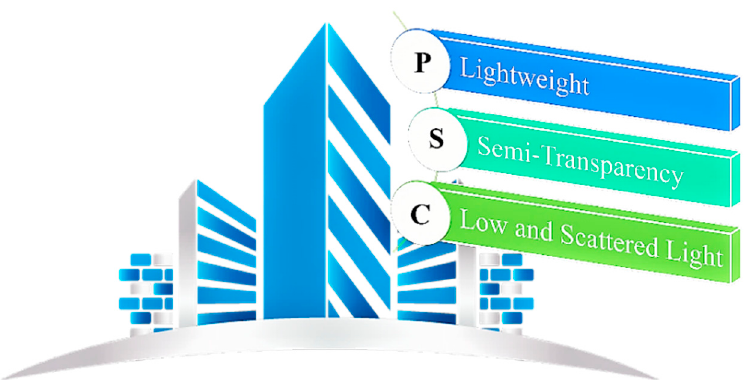
Figure 6. Schematic representation of the suitable PSC features for BIPV.